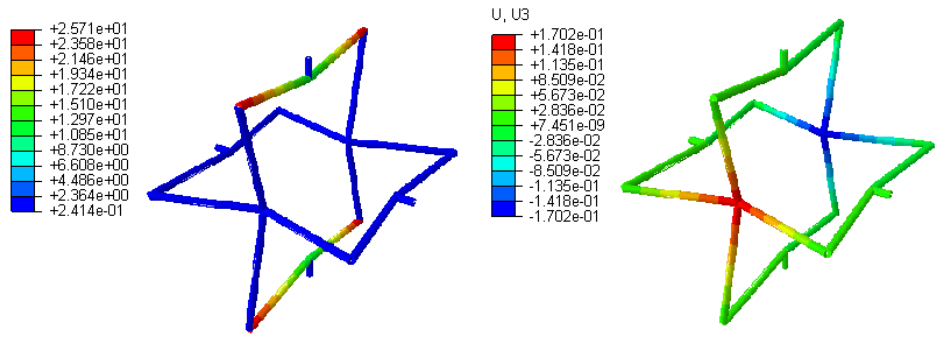
Figure 6. H-method stress distribution and axial deformation after getting a converged